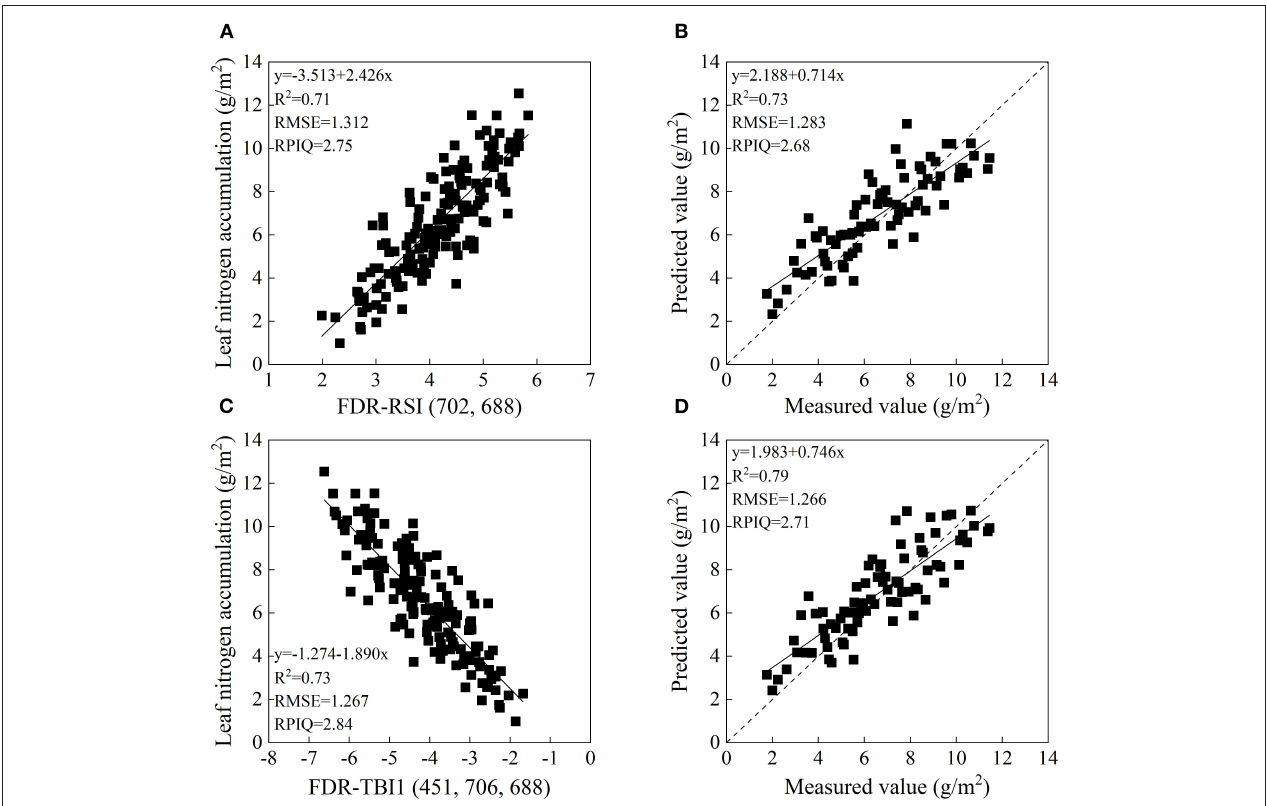
FIGURE 6 | The relationship between leaf nitrogen accumulation (LNA) and FDR-RSI (702, 688) (A) and FDR-TBI1 (451, 706, 688) (C) . Measured and predicted LNA of the validation dataset based on FDR-RSI (702, 688) (B) and FDR-TBI1 (451, 706, 688) (D) .